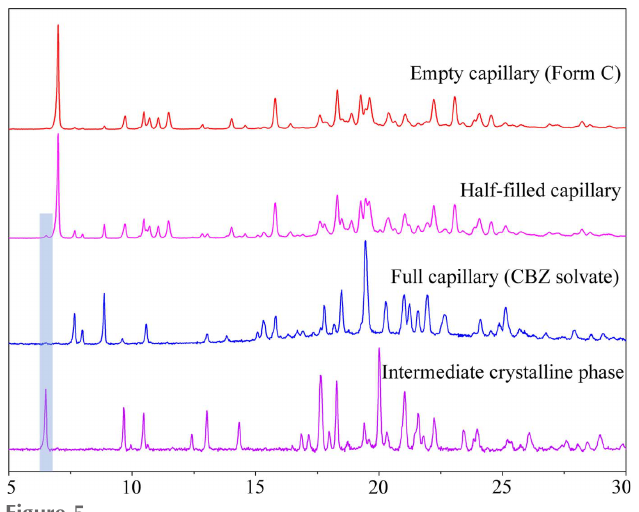
Figure 5 Measured diffraction patterns of the empty capillary (ibrutinib form C), half-filled capillary (ibrutinib form C + CBZ solvate + intermediate crystalline phase), full capillary (CBZ solvate) and intermediate crystal- line phase.